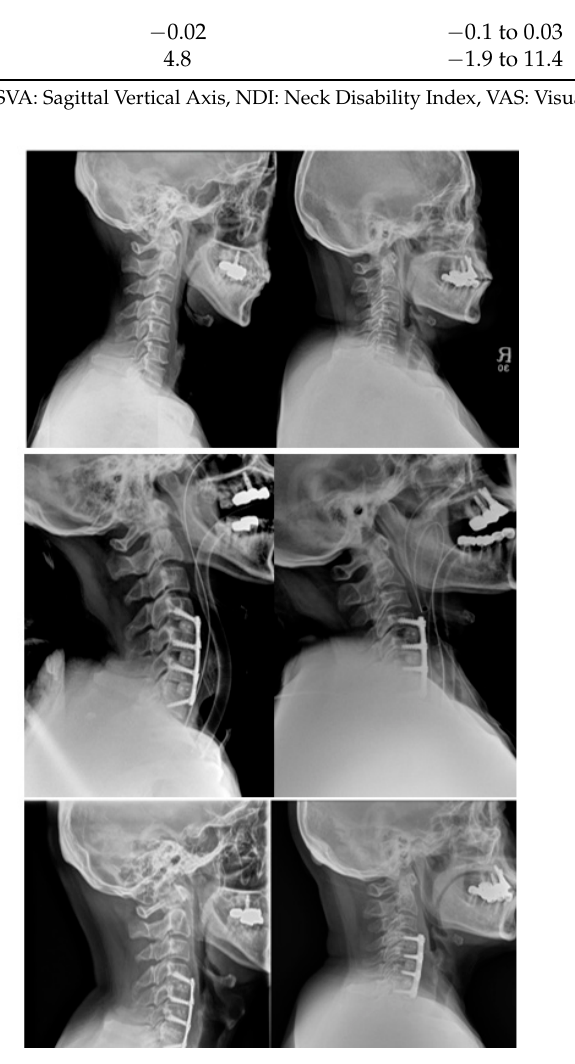
Figure 3. Side by side comparison of the two techniques (images on the left, short plate–high-an- gled screws; images on the right, medium plate–low-angled screws) at pre-op, immediate post-op and at the 1-year follow-up. Images show presence of subsidence on the medium plate–low-angled screw, with decrease in PPD. The lower adjacent segment at 1-year post-op also showed the presence of ALOD.